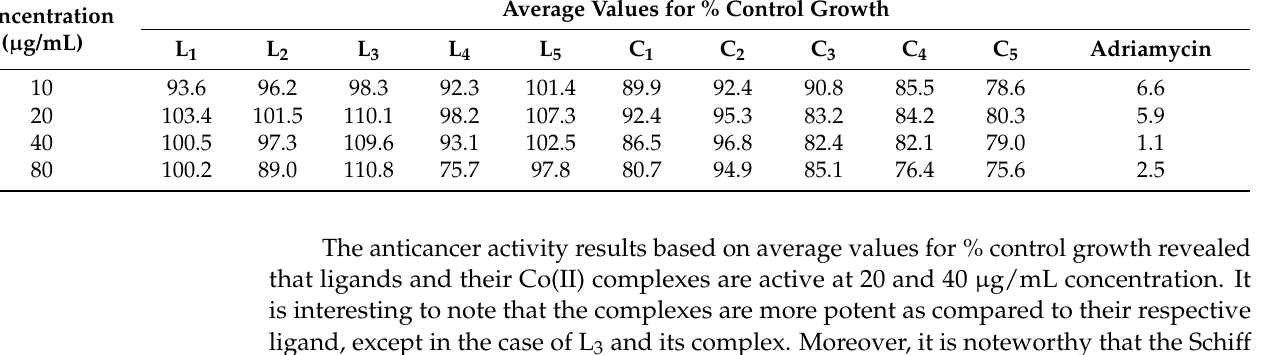
Table 10. Average values for % control growth for the lung cell line